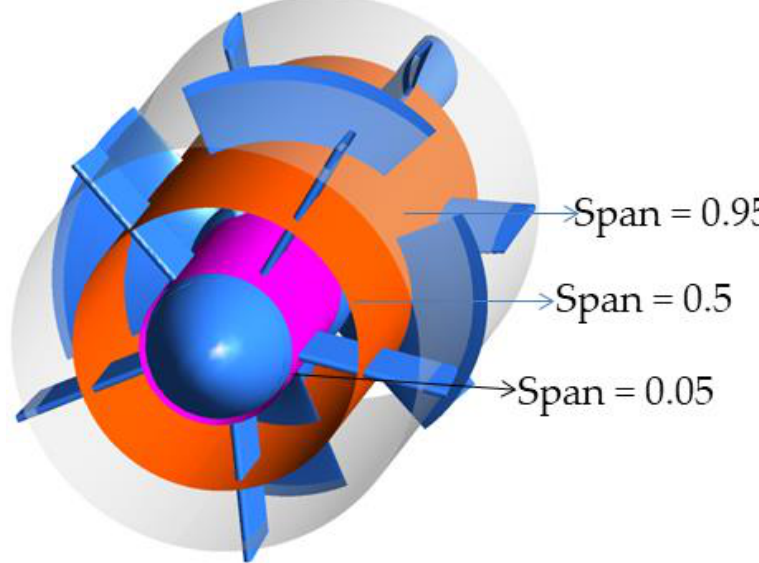
Figure 13 Section of the blade ring of the axial flow pump runner. Figure 13. Section of the blade ring of the axial flow pump